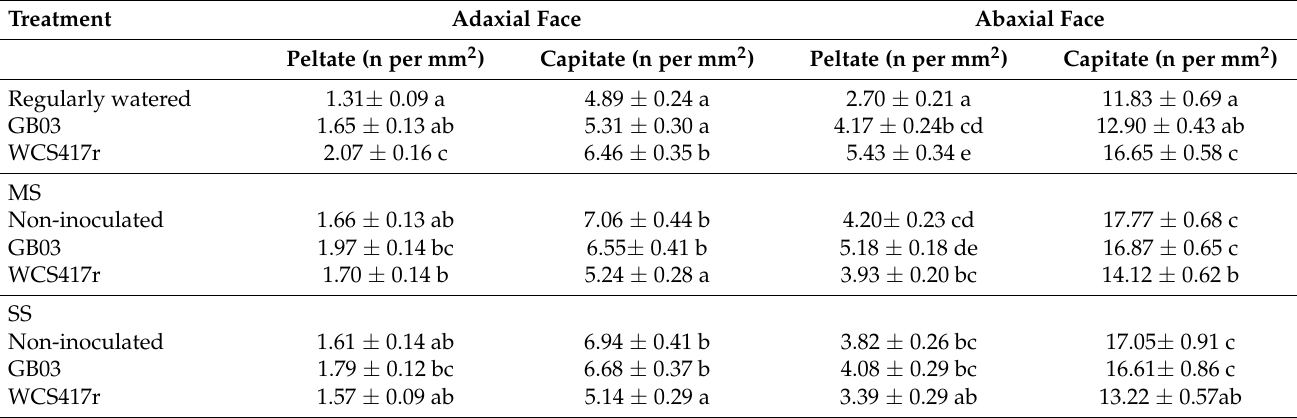
Table 3. Glandular trichome density from peppermint subjected to moderate (MS) or severe drought stress (SS) drought stress and inoculated with different PGPR strains (mean ± SE). Means followed by different letters indicate significant differences between treatments based on Fisher’s LSD test (n = 15–20, p <